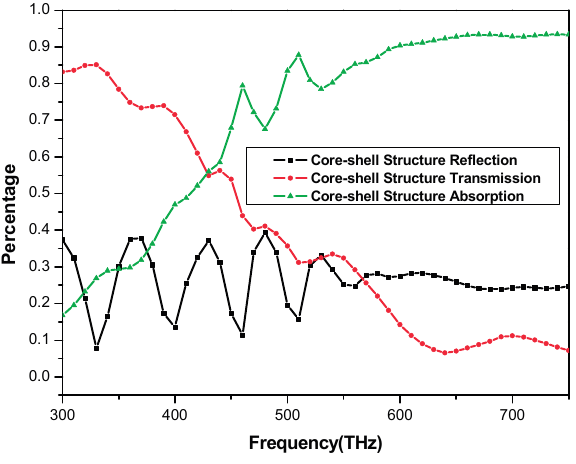
Figure 6. Absorption rate of the core-shell nanowire structure.